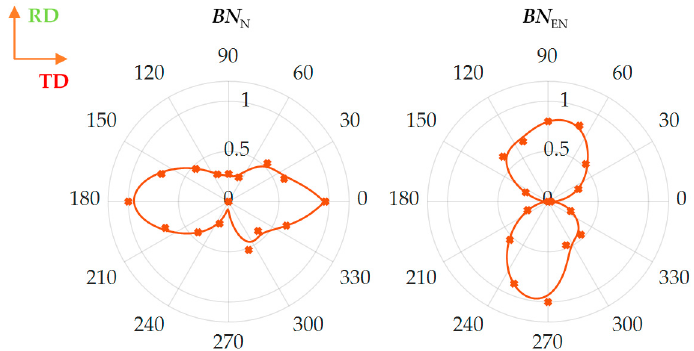
Figure 6. Results of the angular distributions of classical magnetic Barkhausen noise (MBN) parameters, that is the number of events BN N and the energy BN EN derived from time domain representation: markers represents the features values obtained for selected test angles; solid line refers the piecewise fitting result; all results are normalized with respect to maximum value.